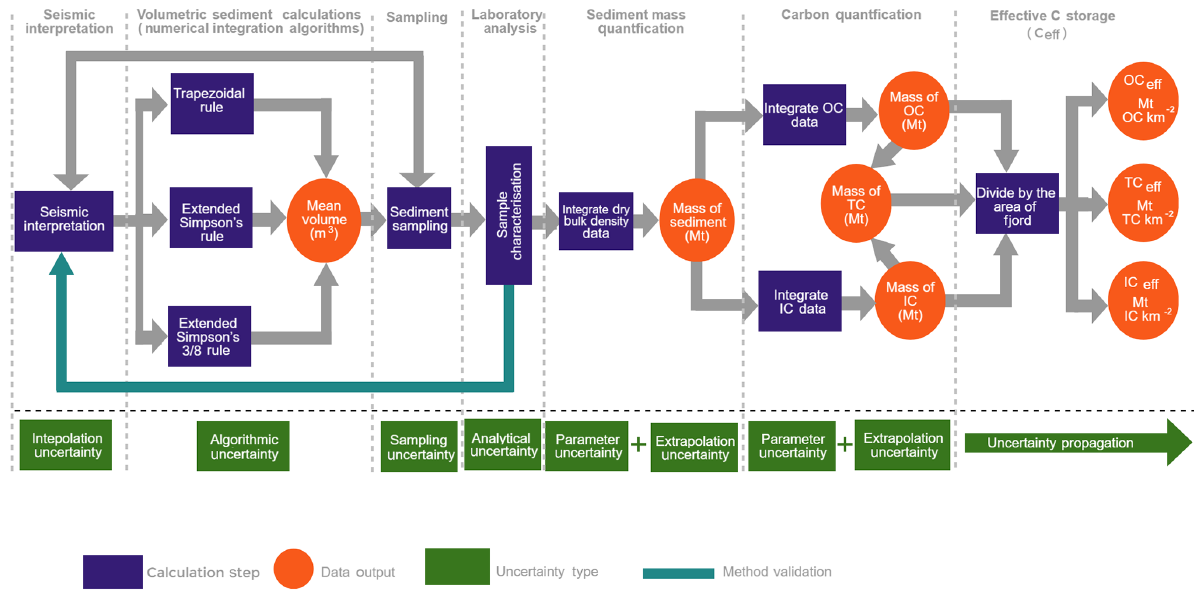
Figure 8. Flow diagram detailing the steps towards calculating the sedimentary C stocks within a fjord with the known uncertainties